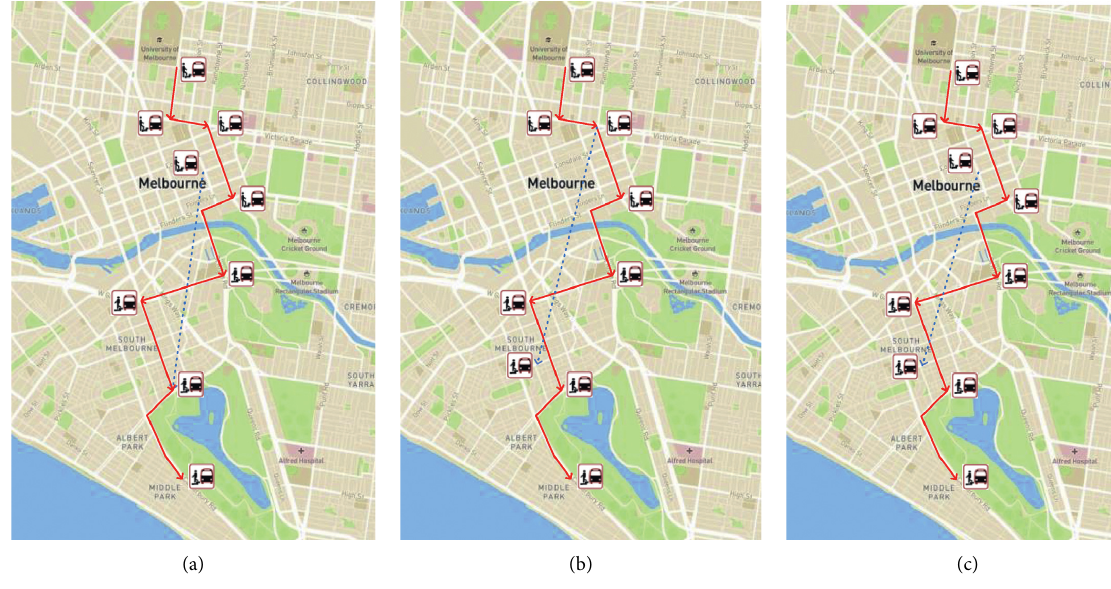
Figure 1: The customized bus